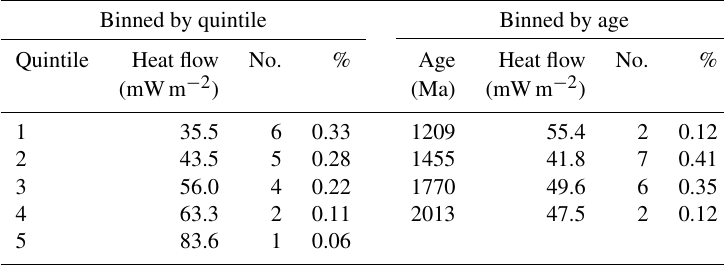
Table 2. Heat flow estimates in proportions based on quintile ranges and age. Binned by quintile Binned by age Quintile Heat flow No. % Age Heat flow